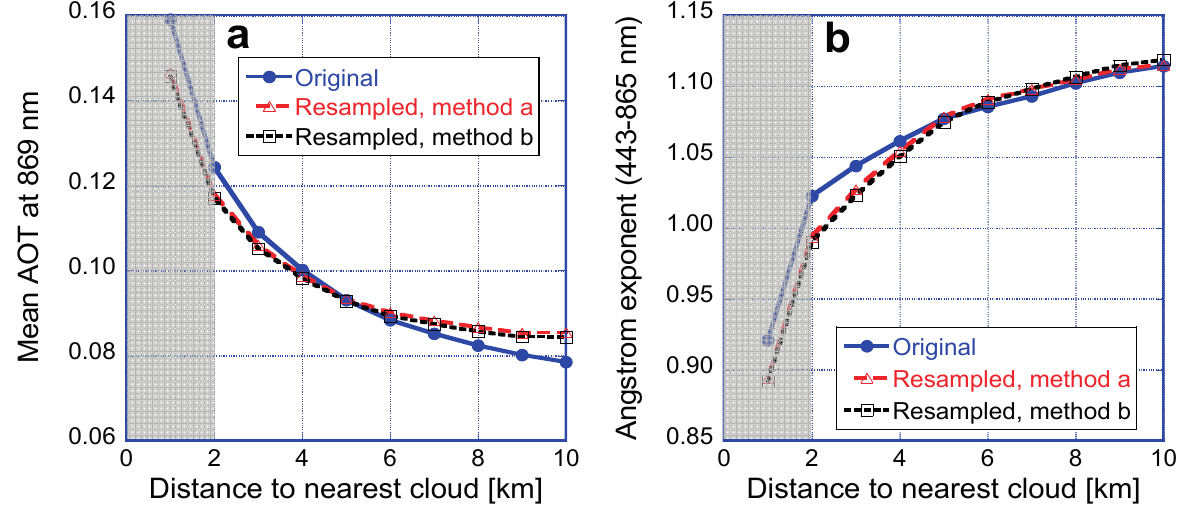
Figure 8. Same as Figure 5, but with the data selection ignoring warnings by both the straylight and sstwarn QA flags. ( a ) Aerosol optical thickness; ( b ) Angstrom exponent.